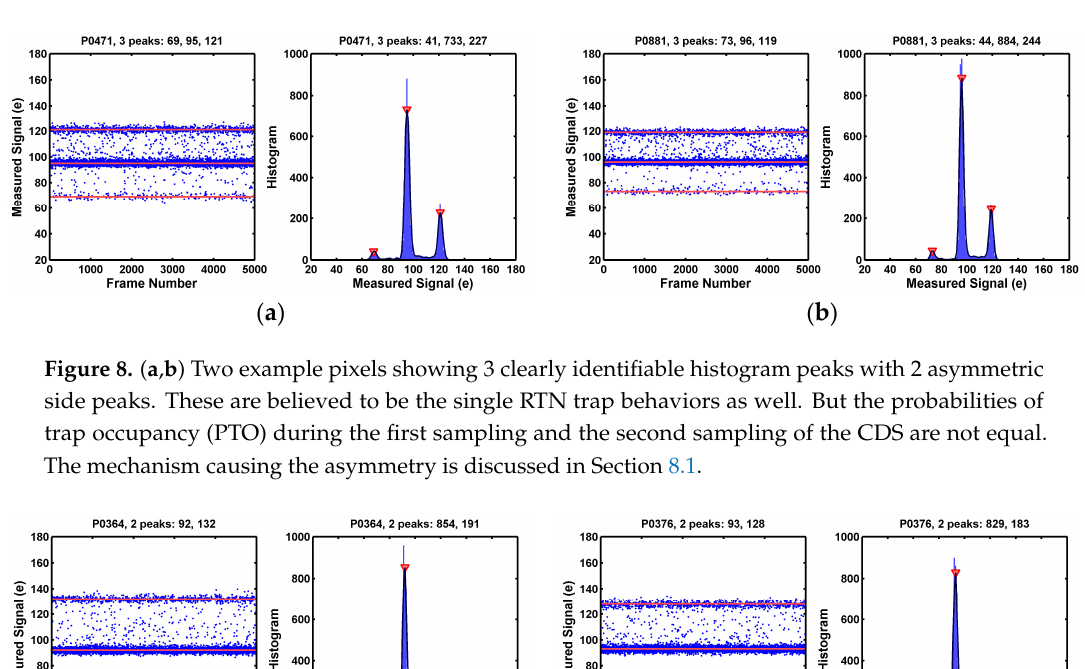
Figure 7. ( a , b ) Two example pixels showing 3 clearly identifiable histogram peaks. This is the signature behavior of pixels with a single RTN trap as the result of the CDS subtraction. The 2 side peaks are symmetric in magnitudes and in populations, which indicates that the probabilities of trap occupancy (PTO) during the first sampling and the second sampling are approximately equal.